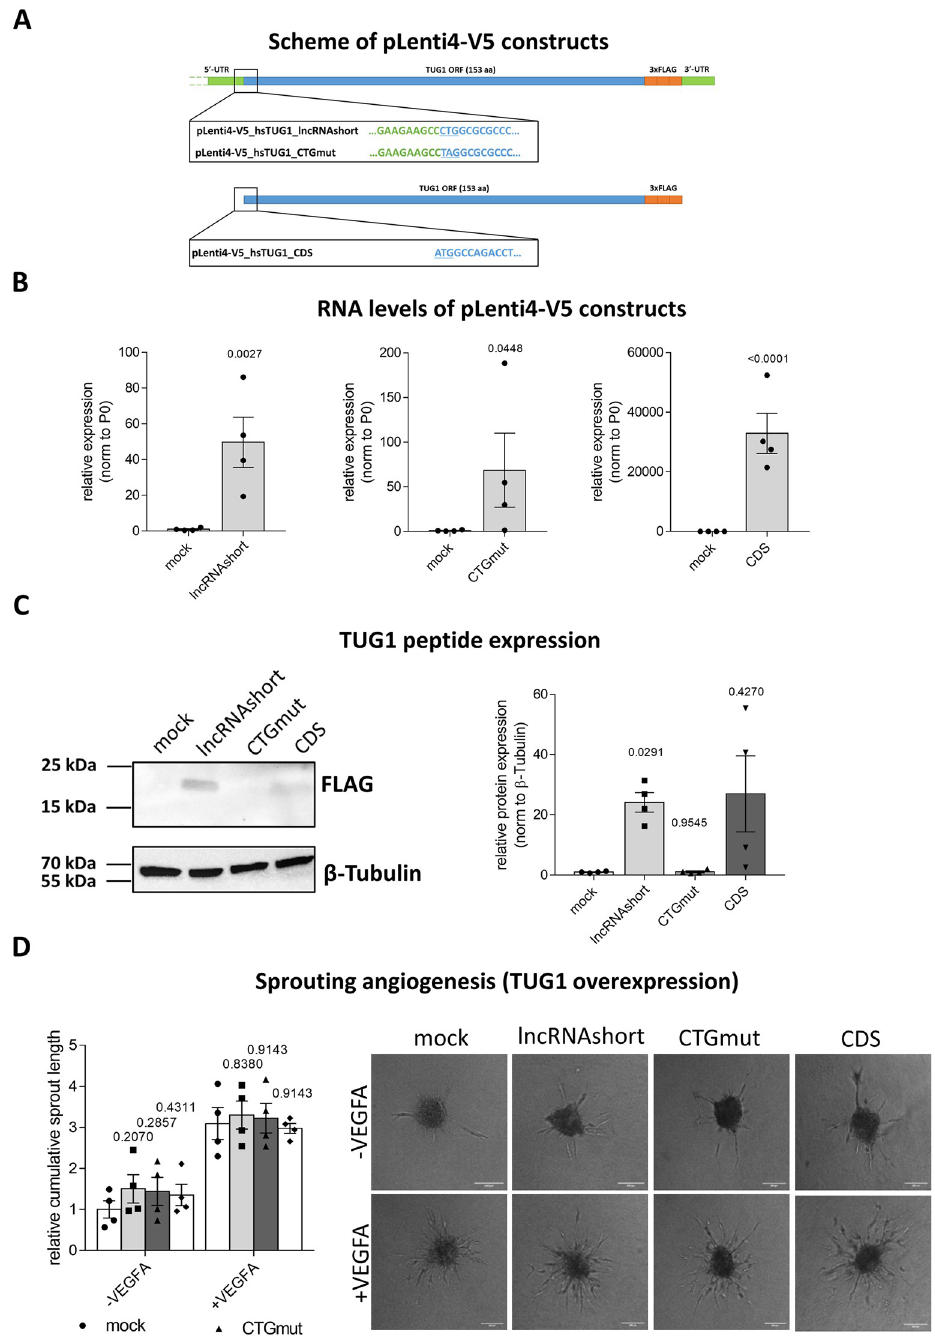
Fig 4. TUG1 protein can be overexpressed in HUVECs, but is not involved in sprouting. (A) Scheme of three pLenti4-V5 plasmids with different inserts for the TUG1 lncRNA and protein coding open reading frame (ORF). PLenti4-V5_hsTUG1_lncRNAshort with the non-canonical start codon CTG representing the wild type sequence containing the information for the protein and the lncRNA, pLenti4-V5_hsTUG1_CTGmut with mutated start codon to stop codon (TAG) containing the information for the lncRNA only and pLenti4-V5_hsTUG1_CDS containing the codon optimized ORF for the TUG1 protein only. 5’- and 3’-untranslated region (UTR) indicated in green, ORF indicated in blue and C-terminal 3xFLAG-tag indicated in orange. Start of ORF sequence underlined and highlighted in blue. (B) RNA levels following lentiviral overexpression of the three different TUG1 proteins in HUVECs as determined by RT-qPCR (n = 4; SEM; ratio paired t-test). (C) Acquisition of TUG1 protein translation after